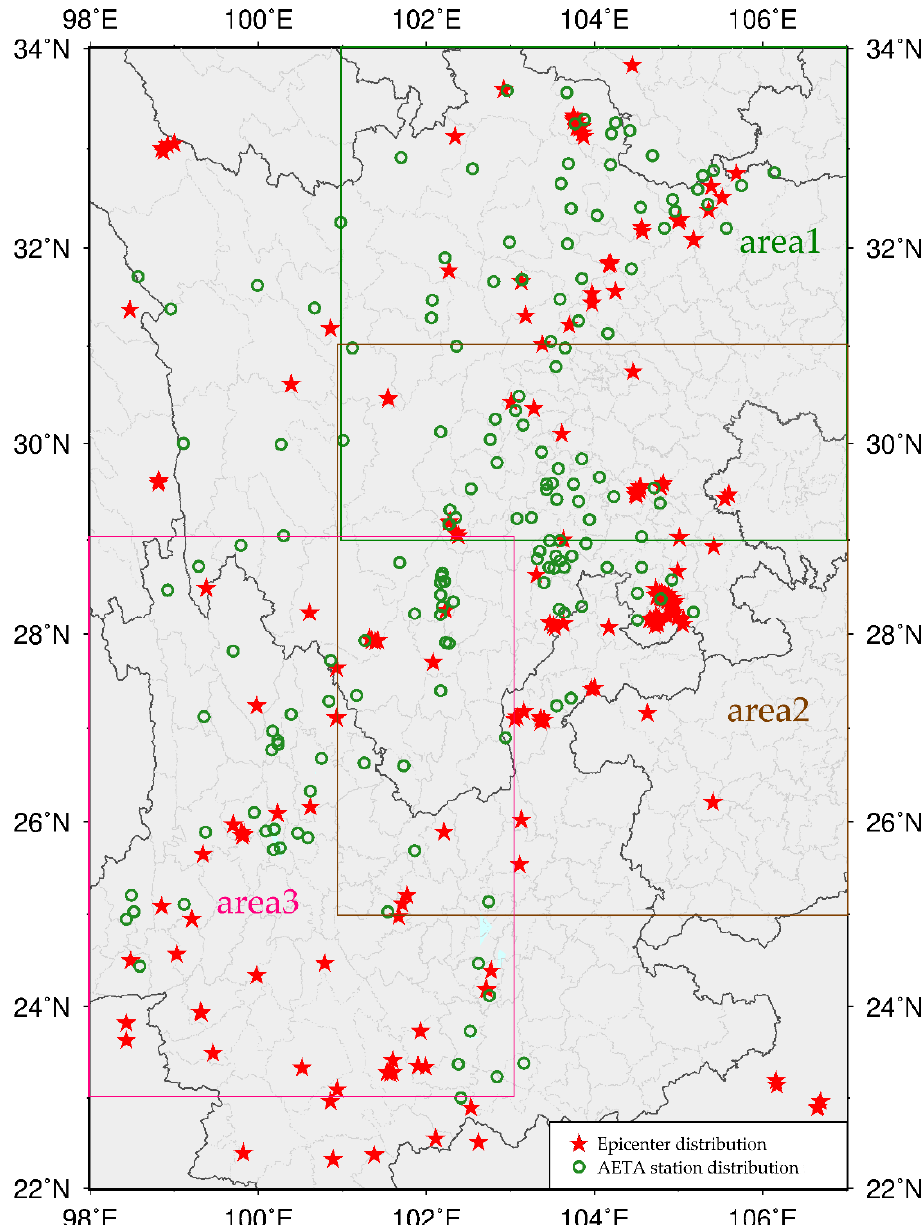
Figure 1. Distribution of earthquakes and stations in Sichuan–Yunnan region.